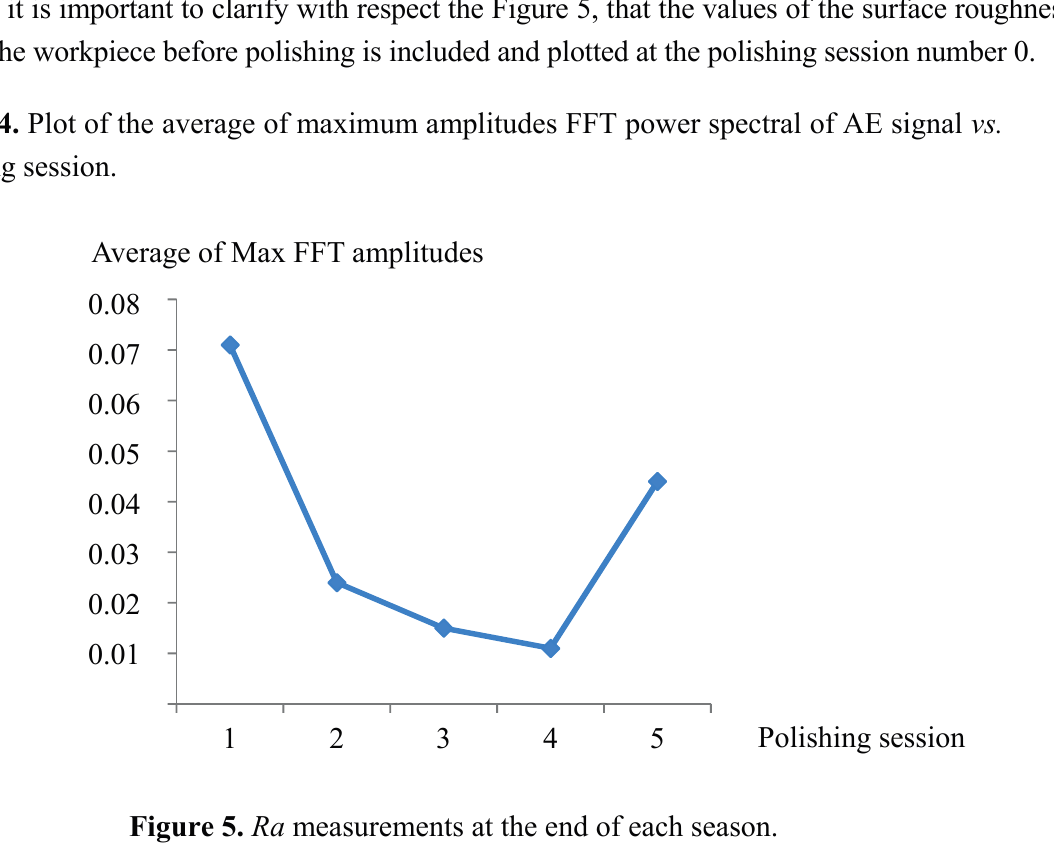
Figure 5. Ra measurements at the end of each